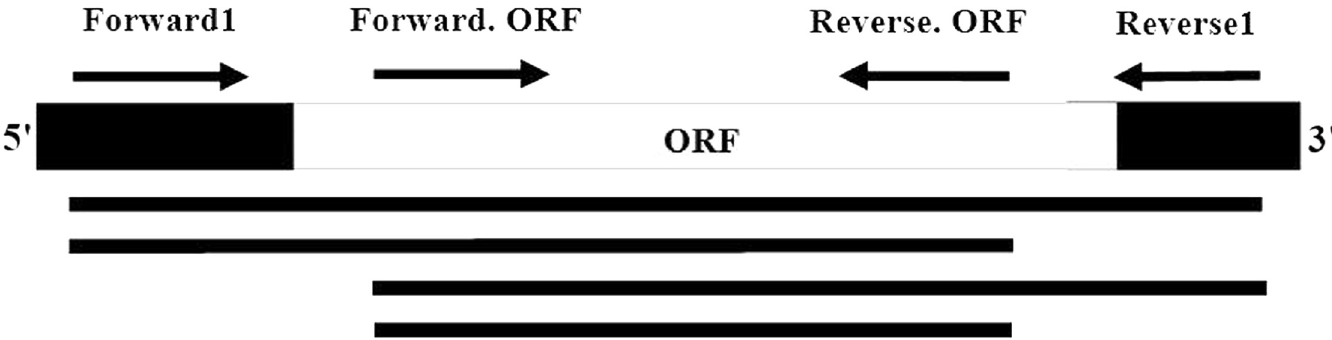
Fig 1. Positions of nested-PCR primers, and the expected lengths of PCR products, containing Alliinase gene. Arrows and lines represent primers and PCR products of each primer pairs,